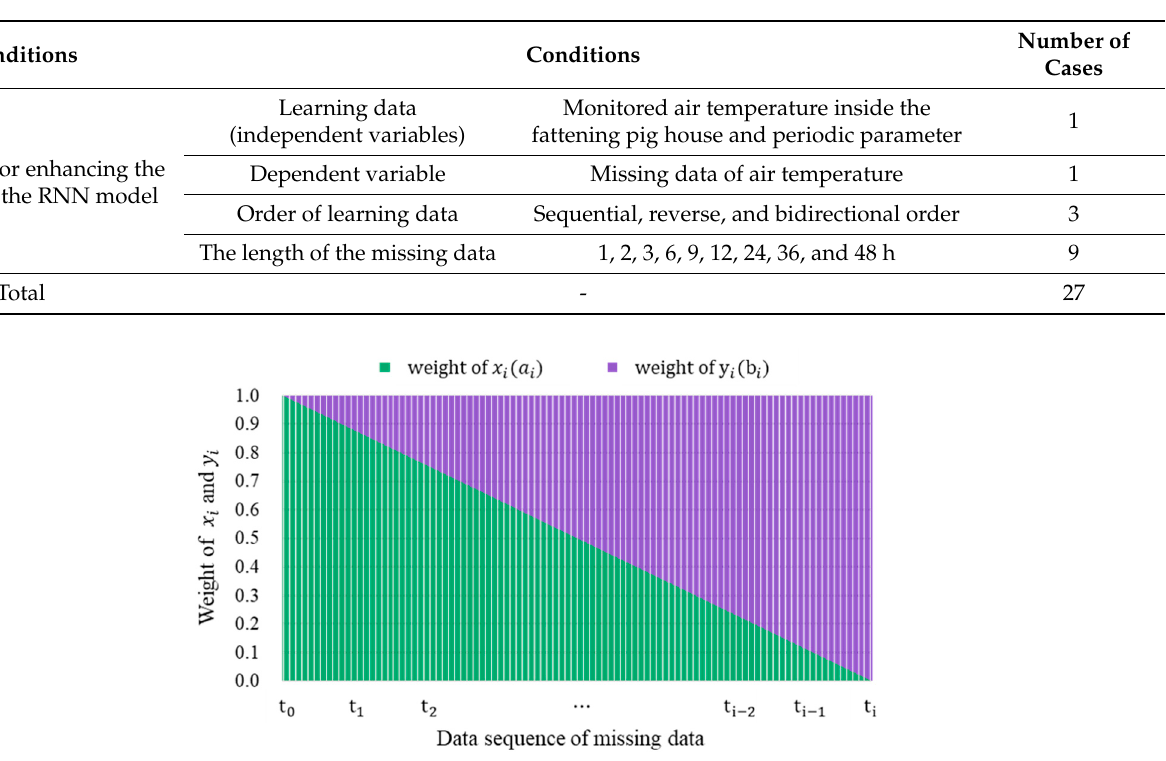
Table 3. Experimental conditions of learning data for developing the RNN model.